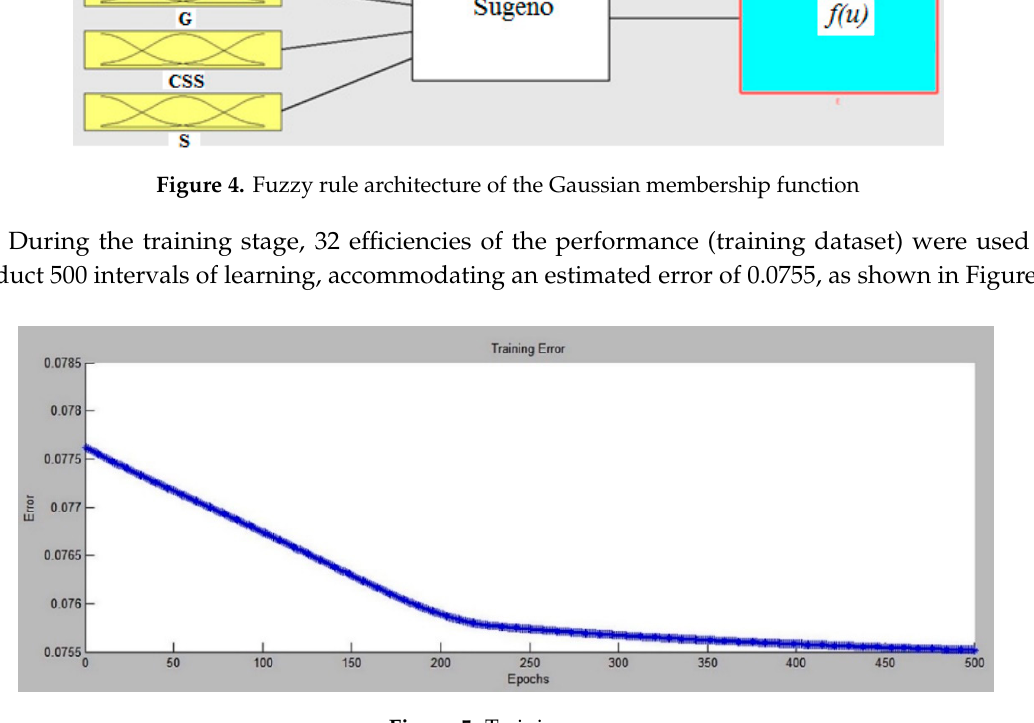
Figure 5. Training error.